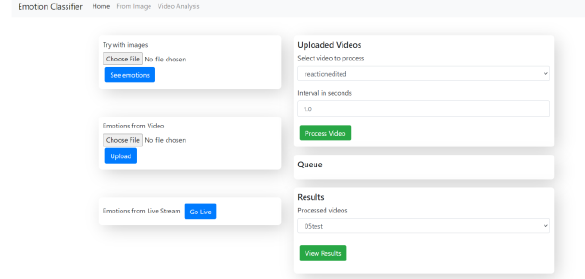
Fig. 8. Main Page.